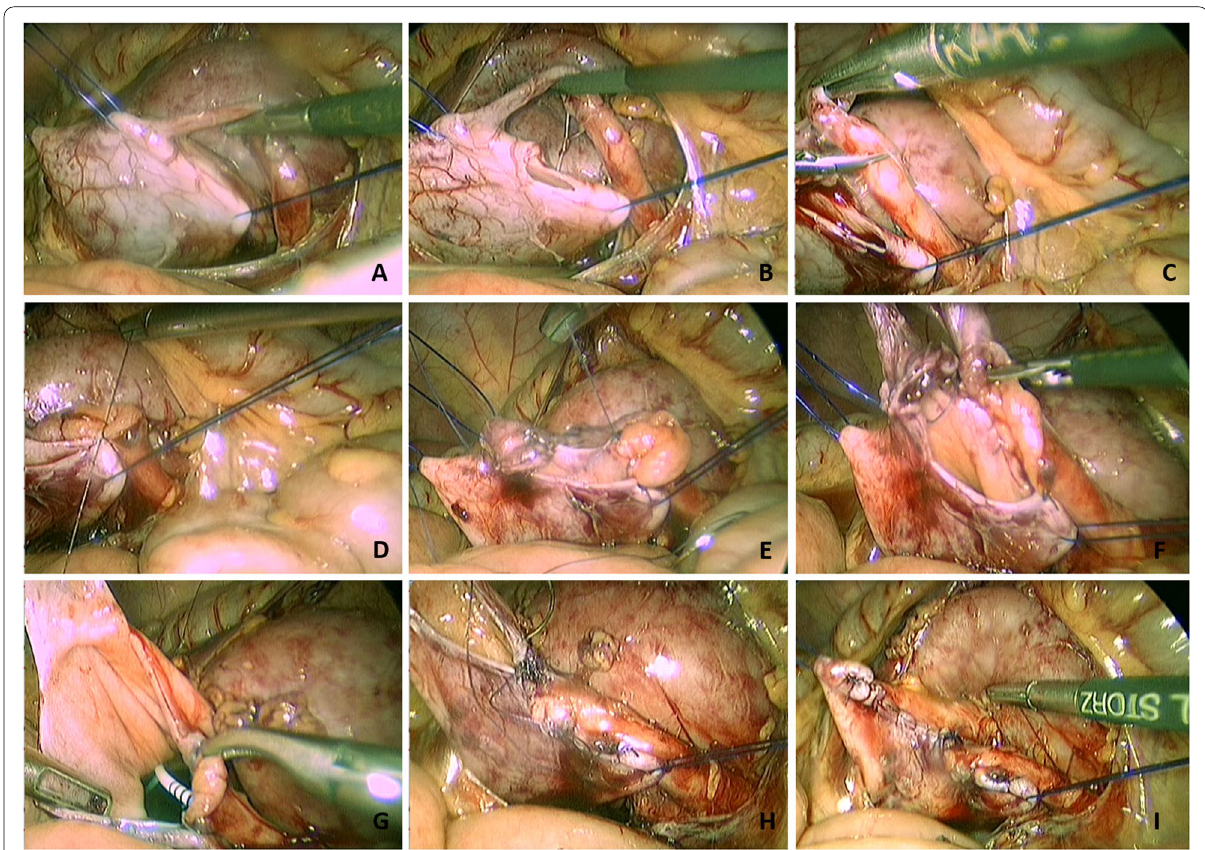
Fig. 3 Operative steps of laparoscopic transperitoneal dismembered Anderson‑Hynes pyeloplasty. A Transmesocolic exposure of UPJ for left sided UPJO. Three polypropylene stay sutures were taken (upper pole, UPJ, lower pole) that emerged from a corresponding points at the anterior abdominal wall. B Opening of the lower pole of the renal pelvis at a dependent site. C Opening and spatulation of the ureter. D The first stitch between the apex of the renal pelvis and the spatulated ureter. E Beginning of the posterior wall anastomosis. F Completion of the posterior wall anastomosis followed by dismembering the UPJ. G Insertion of the double J catheter. H Fashioning of the anterior wall of the uretro‑pelvic anastomosis over the double J catheter. I Closure of the remaining renal pelvis edge to